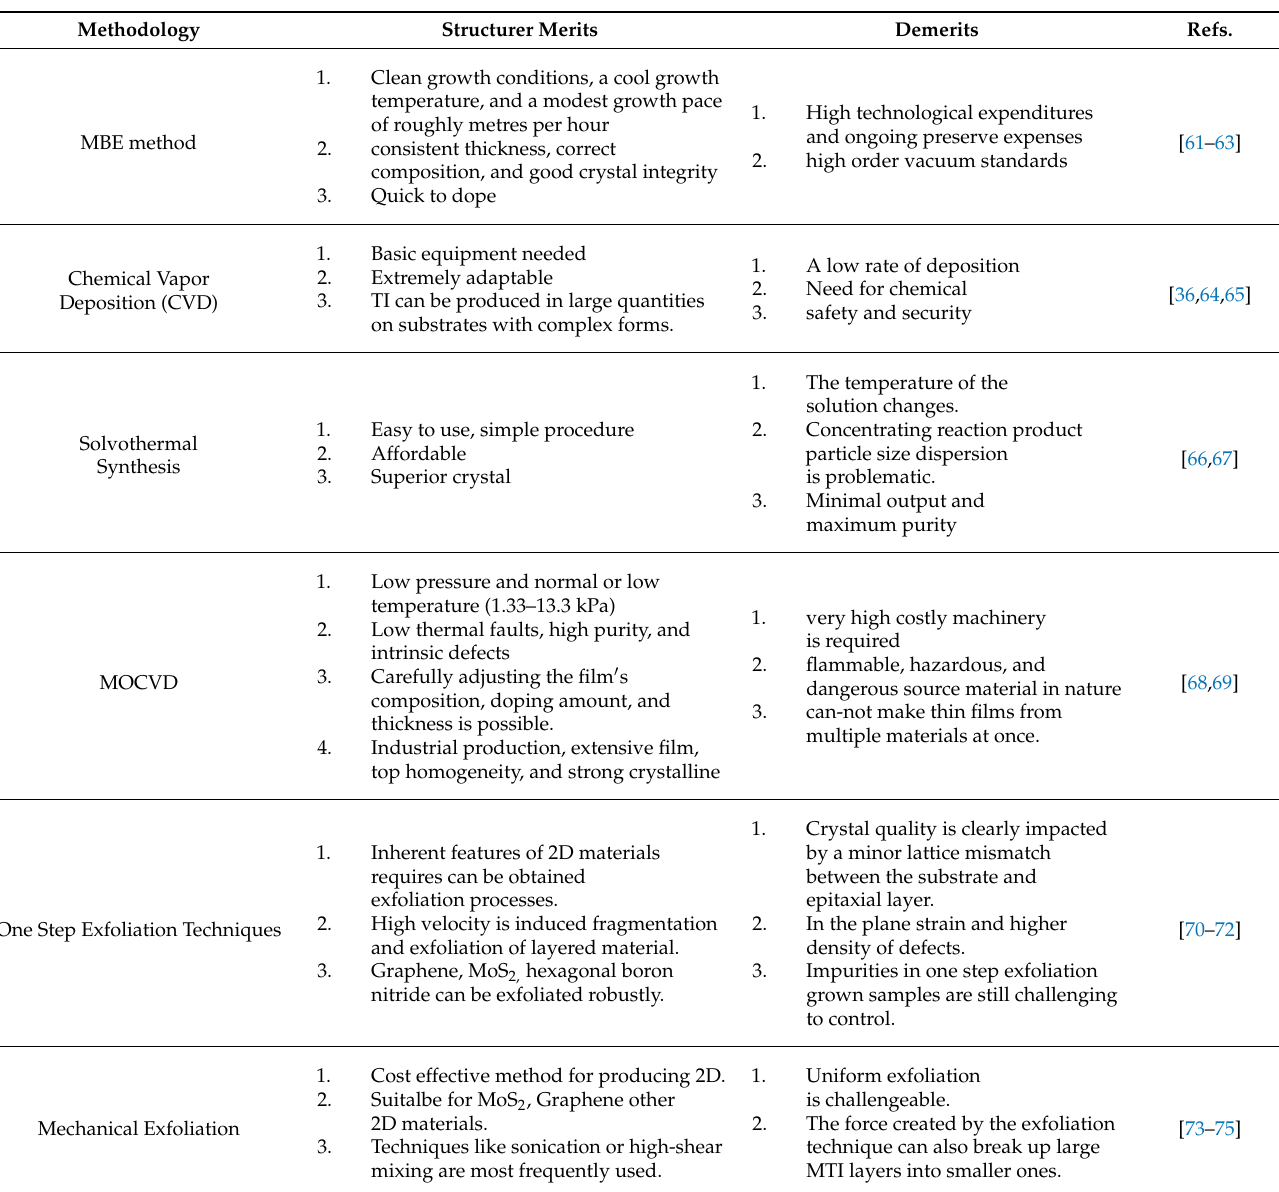
Table 2. Comparison of various preparation